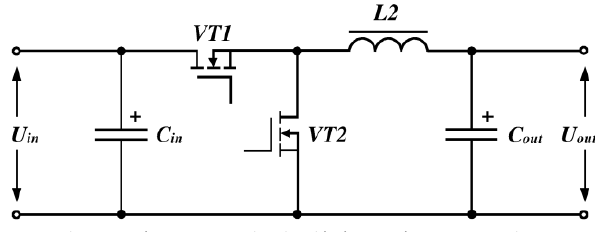
Fig. 9. Buck-converter circuit with the synchronous transistor.